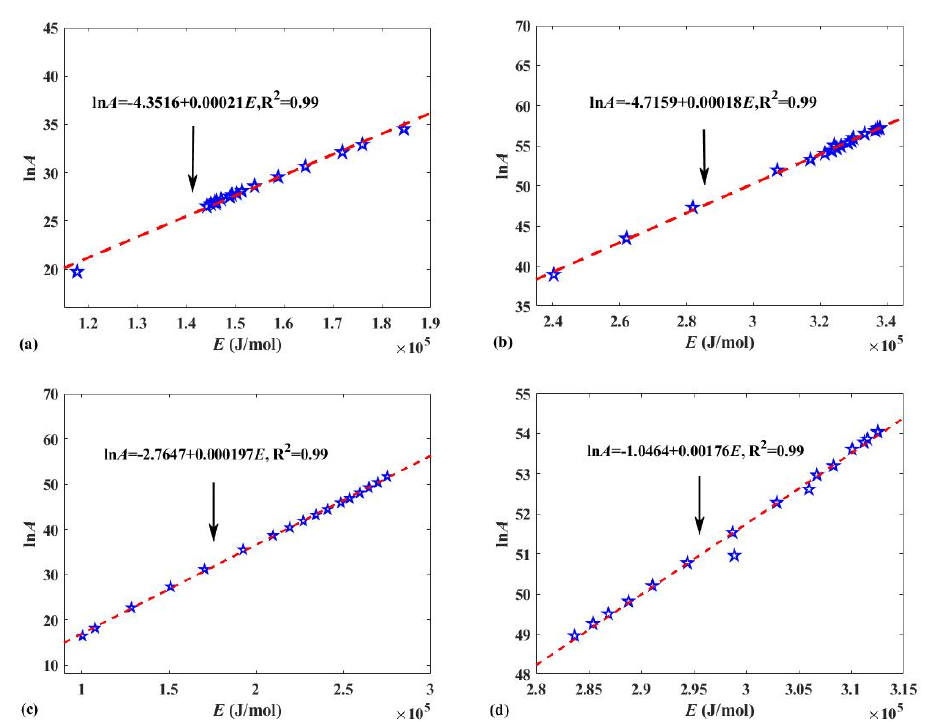
Figure 7. ( a ) Compensation effect between ln( A ) and E of Reaction I; ( b ) compensation effect between ln( A ) and E of Reaction II; ( c ) compensation effect between ln( A ) and E of Reaction A; ( d ) compensation effect between ln( A ) and E of Reaction B.